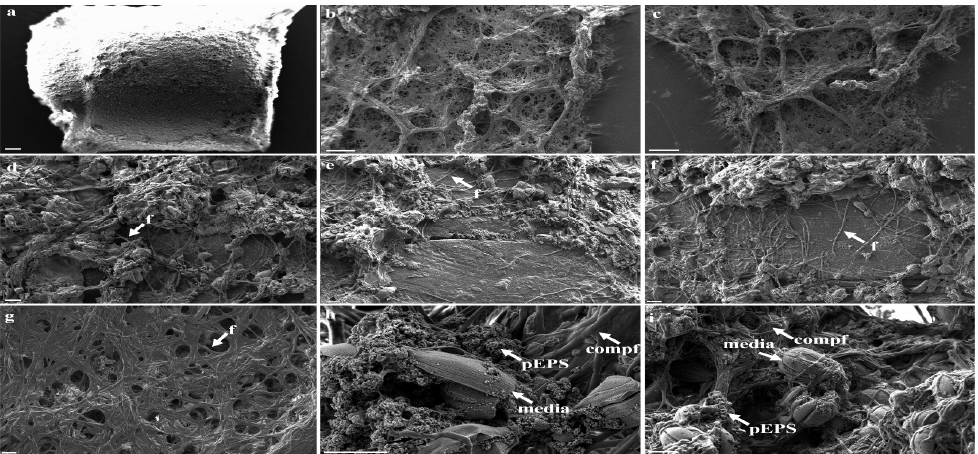
Figure 3. Scanning electron microscopy images of PA pellet incubated in seawater for two years. ( a – j ) Reticulate structures forming a mature biofilm consisting of ( e – g ) filamentous structures ( f ) and marine elongated diatoms (media). pEPS indicate particulate EPS. Higher magnification reveals filamentous cells being compartmented filaments (compf) resembling filamentous unbranched algae or cable bacteria. Scale bars: ( a – c) 100 µ m, ( d – i ) 10 µ m.